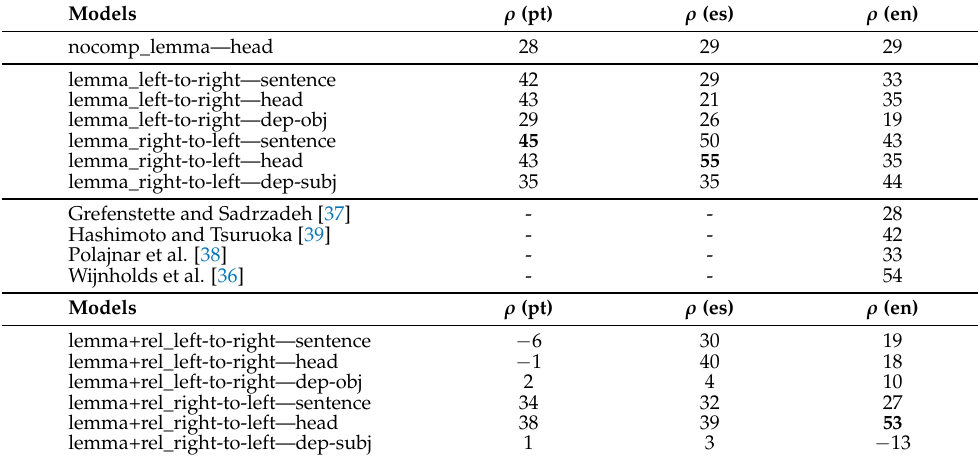
Table 1. Spearman correlation between different configurations of DepFunc and human judgments on subject-verb-object expressions. Correlation was computed on benchmarks for English (en), Portuguese (pt) and Spanish (es). Top: scores with configurations based on vectors of lemmas. Bottom: scores with configurations based on lexico-syntactic units (lemma + rel).